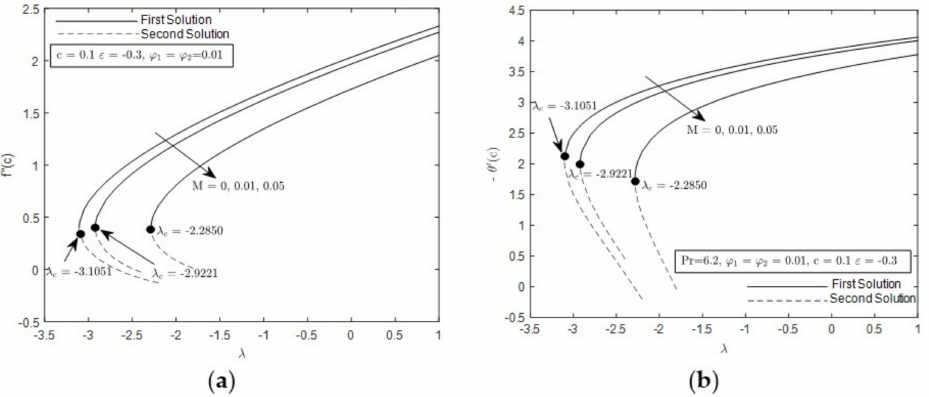
θ (cid:48) ( c ) with mixed convection −